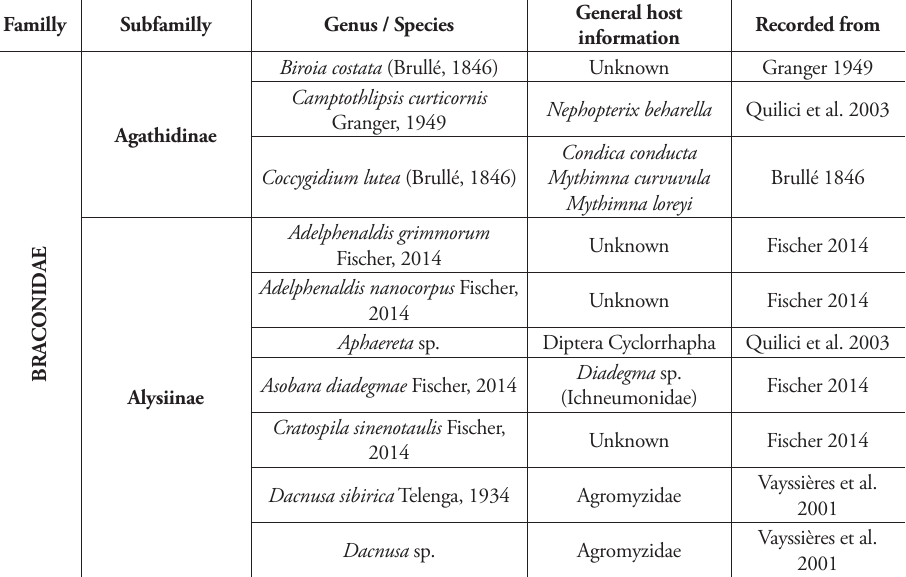
General host Recorded information